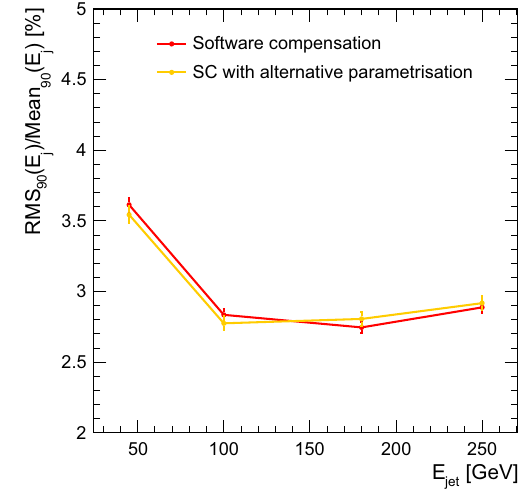
Fig. 10 Jet energy resolution for SC applied at the reclustering stage for two different parametrisations of the cell energy weights, the expo- nential weight parametrisation (red) and the alternative parametrisation inspired by semi-digital energy reconstruction (orange)